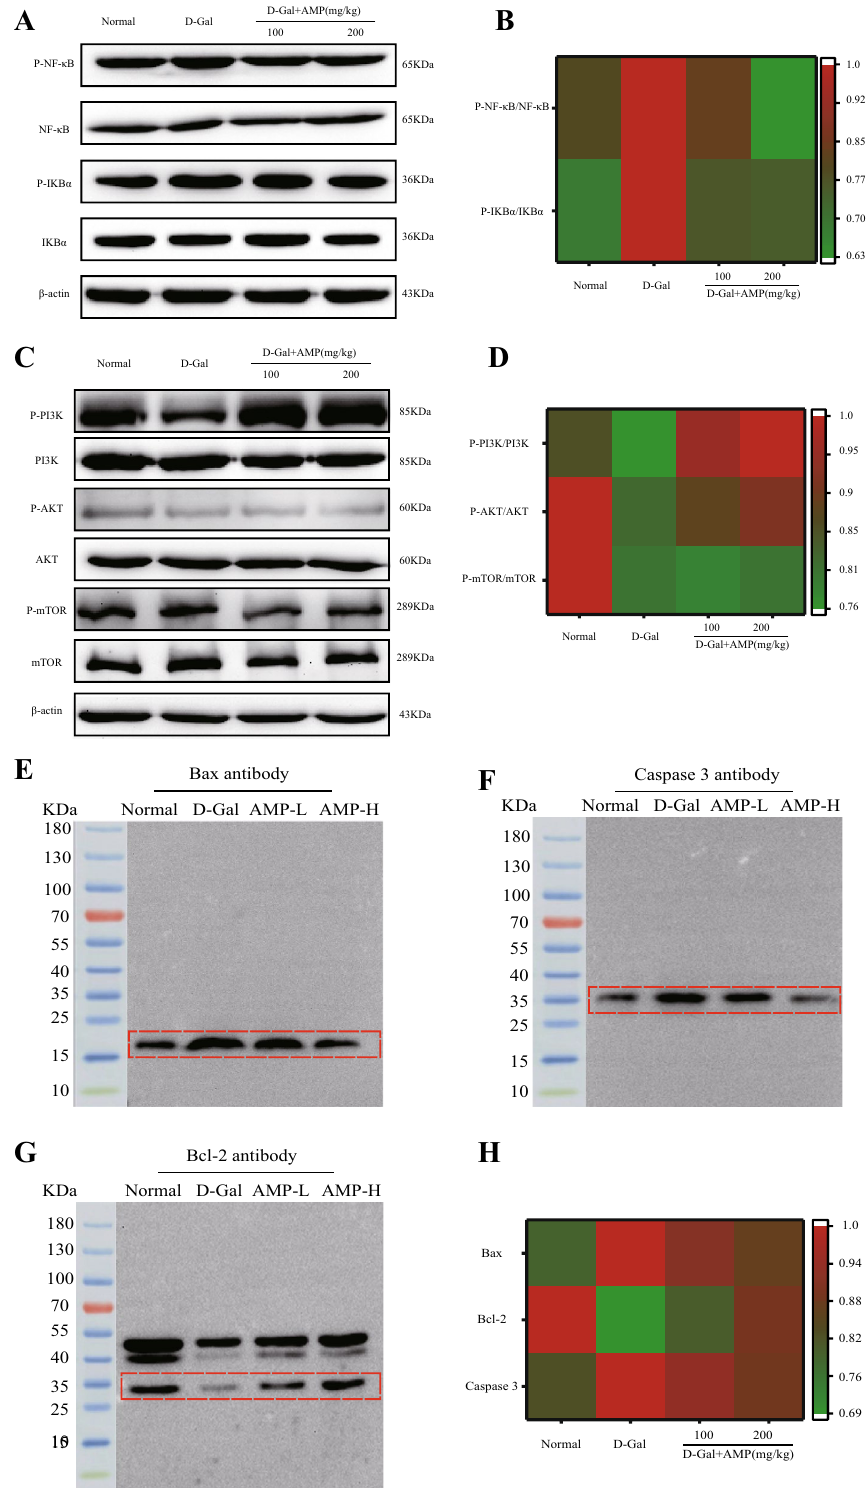
Figure 5. AMP exerts an anti-aging effect in mice by regulating NF-κB-mediated inflammation and PI3K/ AKT/mTOR anti-apoptotic pathway. ( A , B ) The proteins expression of NF-κB and IκB-α in mice of brain tissue, and heat map analysis of NF-κB signaling pathway expression protein levels. ( C – H ) The proteins expression of p-PI3K/PI3K, p-AKT/AKT, p-mTOR/mTOR, Bax, Caspase 3 and Bcl-2 in mice of brain tissue, and heat map analysis of PI3K/AKT/mTOR and its downstream protein levels. Data are expressed as the mean ± standard deviation (S.D), n = 10. *p < 0.05 or **p < 0.01 vs. normal group; # p < 0.05 or ## p < 0.01 vs. D-Gal group. Chemical imaging was collected using Bio-Rad Imaging System version VersaDoc 3000 (https:// www. bio- rad. com/). The heatmap was constructed using the online tool Morpheus (https:// softw are. broad insti tute. org/ morph